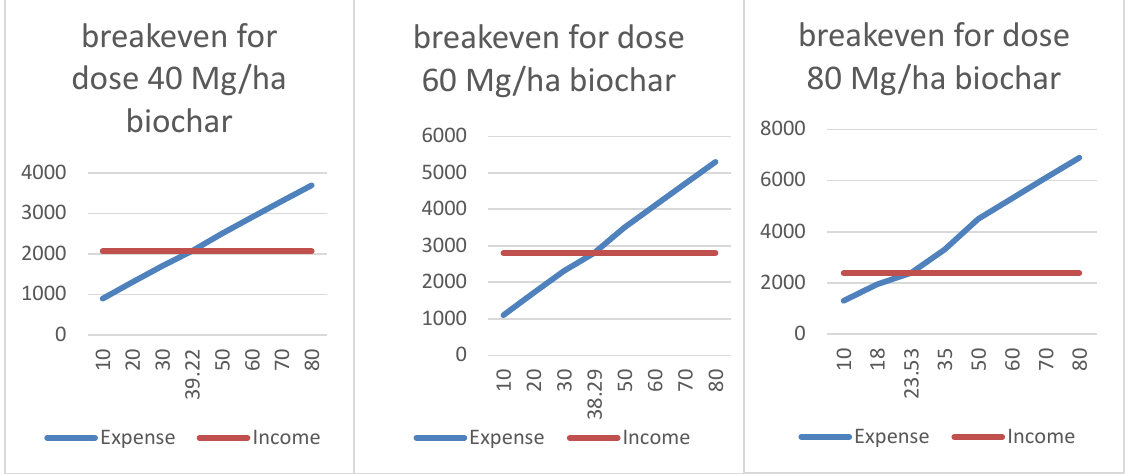
Figure 6. Breakeven price (in USD).